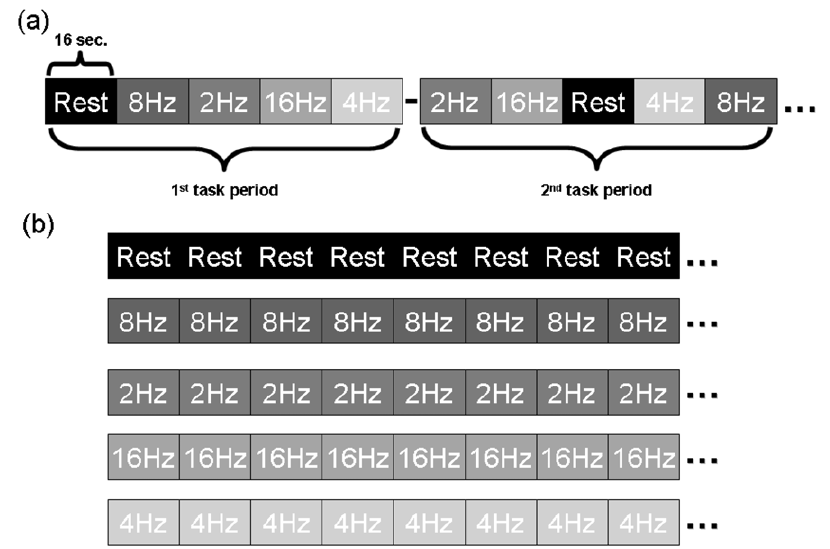
Figure 4. The design of experiment in our study.